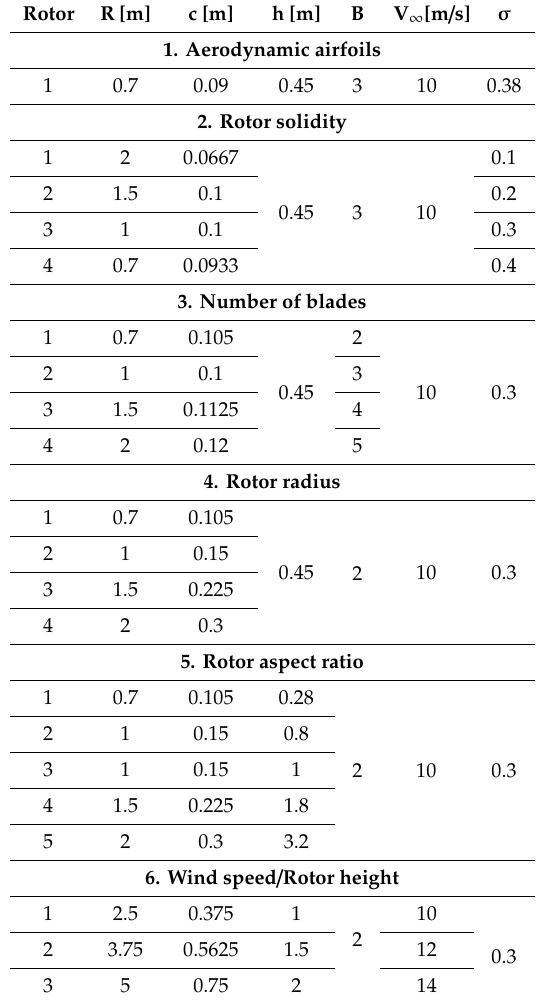
Figure 11. Performance curve for different solidity